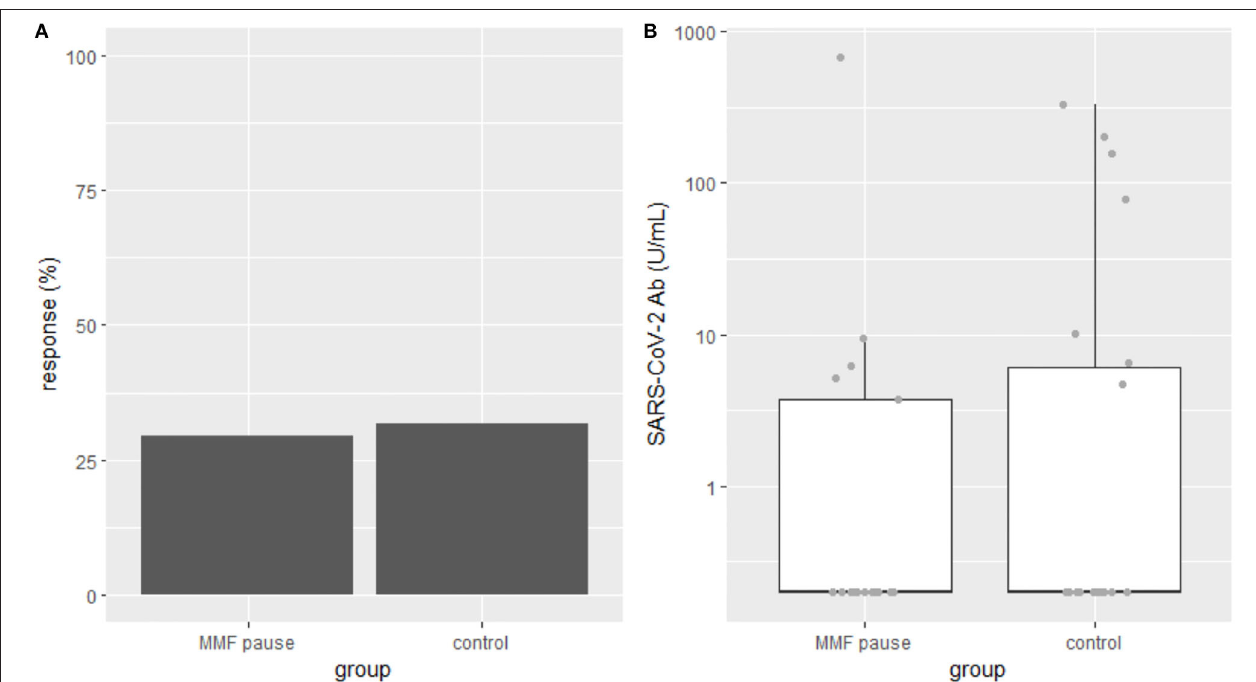
FIGURE 2 | (A) Seroconversion rate: Bar chart comparing response rates in KTR with MPA pause and control group following 4th/5th SARS-CoV-2 vaccination with BNT162b2. Response to vaccination was defined by reaching antibody levels above 0.8 U/mL on the Roche Elecsys platform. (B) Antibody levels following vaccination: Boxplots comparing antibody levels between MPA pause and control group.